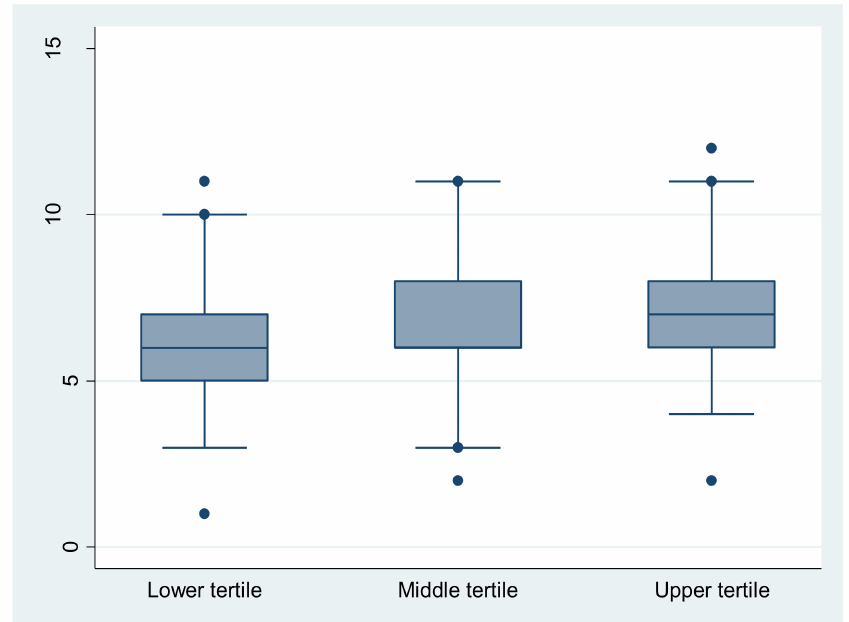
Figure 2. Distribution of MEDAS score over household welfare proxy. Significant difference for the mean MEDAS score between the three economic classes ( p < 0.001). A post hoc analysis showed that a significantly higher mean score is noticed for high economic level (upper tertile) compared to medium ( p = 0.025) and low economic classes ( p <